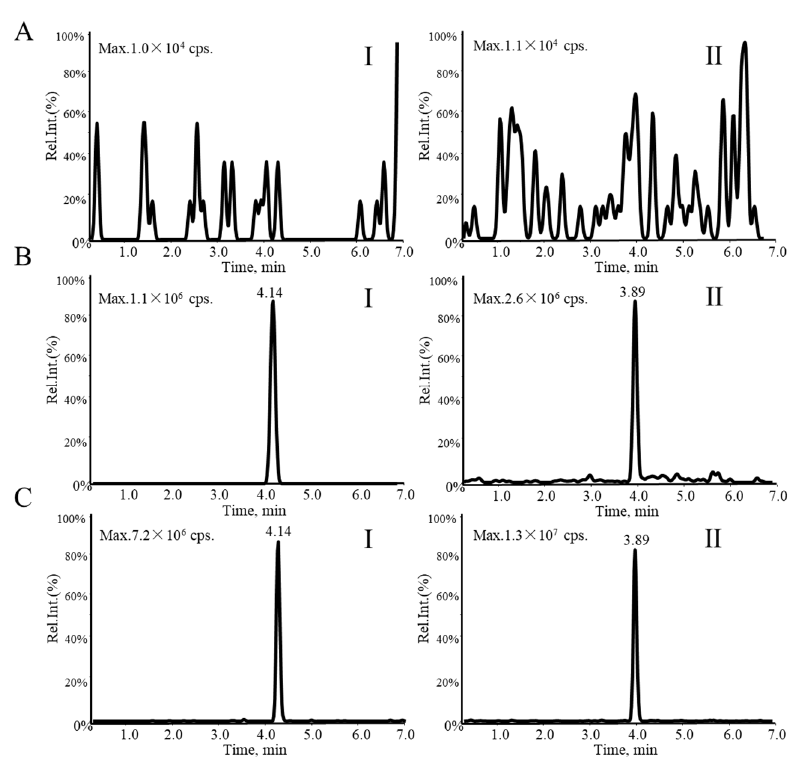
Figure 3. LC-MS 3 chromatogram of voriconazole (I) and carbamazepine-d2,15N (II) in ( A ) blank plasma, ( B ) at the LOQ with 0.25 µ g/mL voriconazole and 5 µ g/mL IS, and ( C ) a plasma sample. Table 2. Inter- and intra-day precision and accuracy for voriconazole in human serum (data are based on assay of six replicates on three different days).